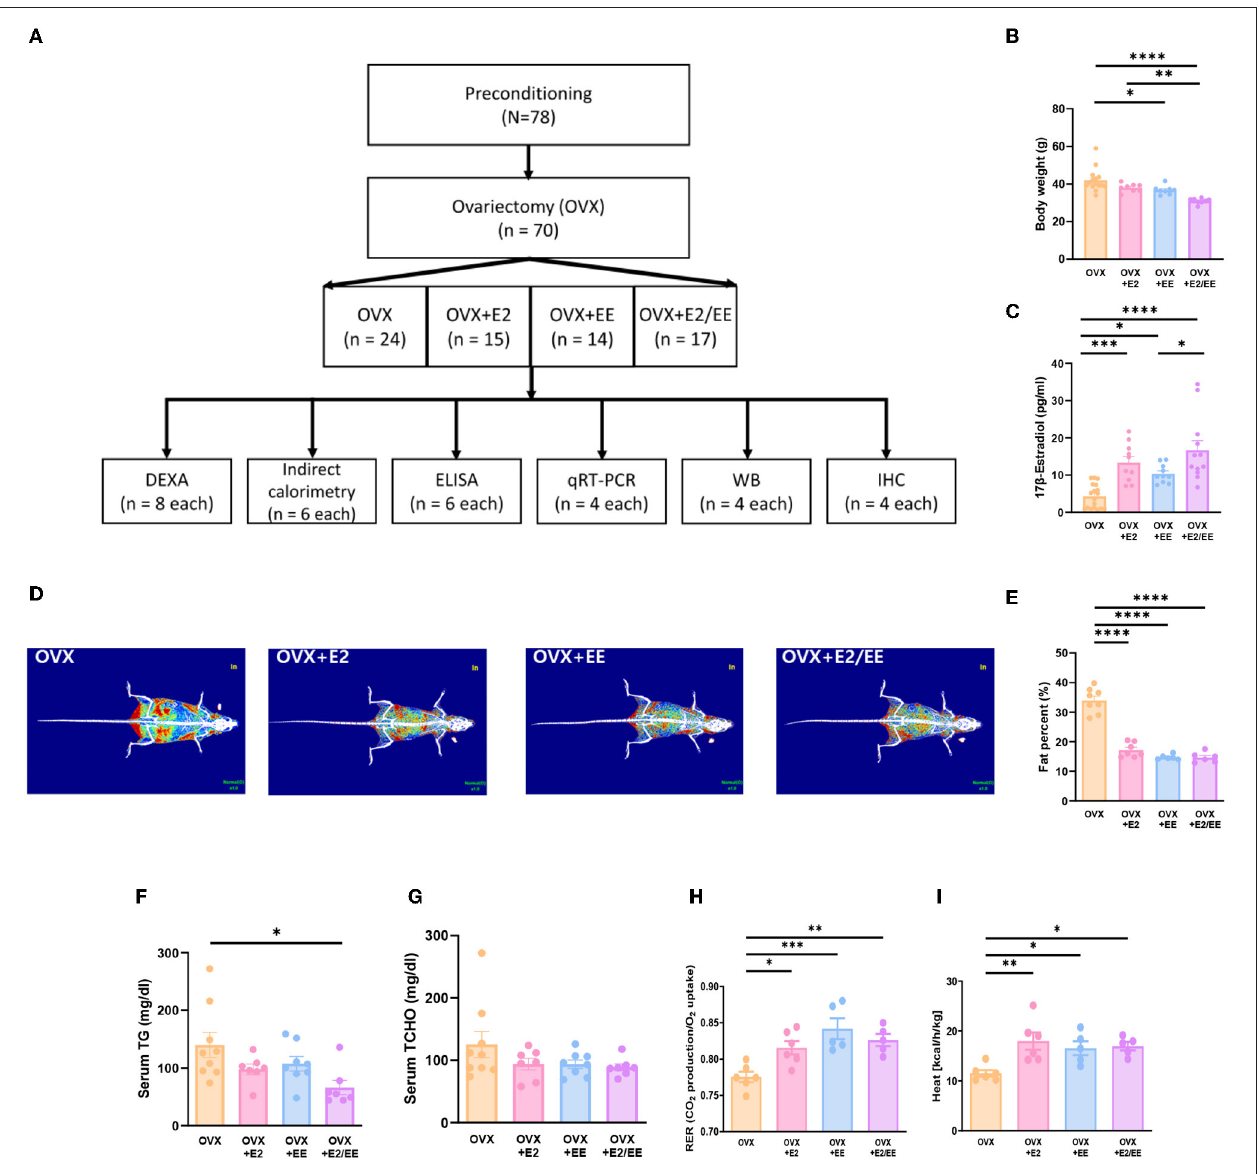
FIGURE 7 | Differential metabolic change following estrogen treatment and exposure to EE in OVX models. (A) Experimental scheme for OVX models. (B) Body weight of OVX groups after the treatments (E2 and/or EE) ( n = 10–18 per group). (C) Measurement of serum 17 β -estradiol ( n = 10–18 per group). (D) Representative DXA image from each group. (E) Percentage body fat ( n = 6–8 per group). (F) Serum triglyceride ( n = 7–9 per group). ( G ) Serum total cholesterol ( n = 7–9 per group). (H) Respiratory exchange ratio ( n = 5–6 per group). (I) Heat ( n = 5–6 per group). One-way ANOVA with Tukey multiple comparison test. Data represented are means ± SEM. * p < 0.05, ** p < 0.01, *** p < 0.001, and **** p <